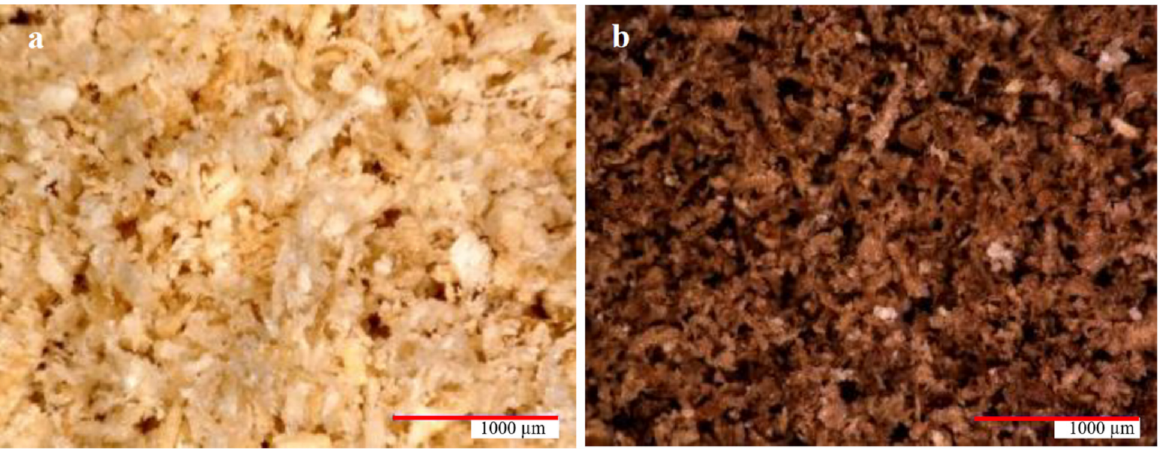
Figure 6. Microscopic image (magnification 50 × ) of ( a ) oak wood flour and ( b ) American walnut wood flour.